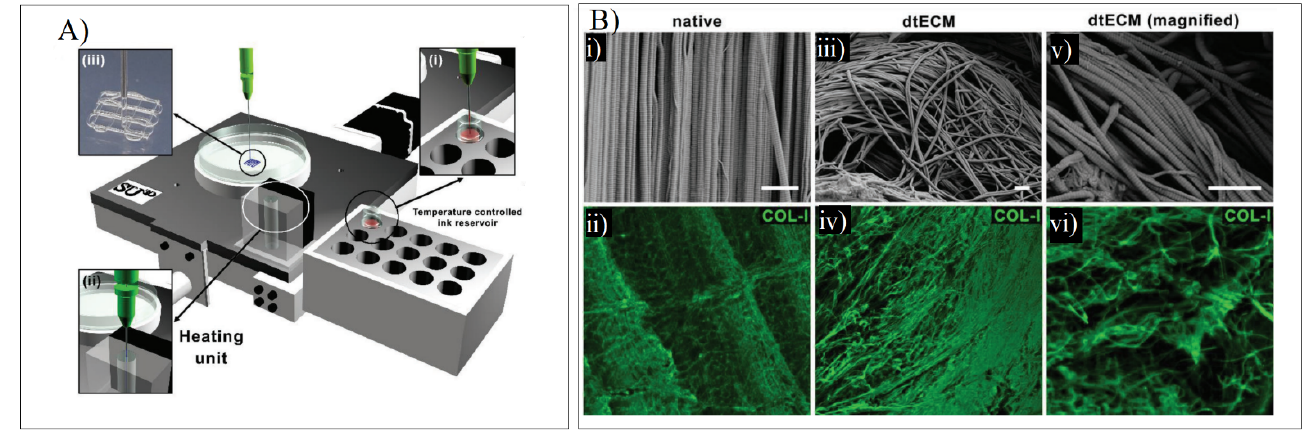
Figure 11. ( A ) Schematic representation of the printing process where the bioink from a reservoir ( i ) is taken to the heating unit ( ii ) to bioprint the scaffold ( iii ). ( B ) SEM and COL-I immunostaining in native tendon ( i , ii ) and dECM tendon ( iii – vi ). Adapted from [73].